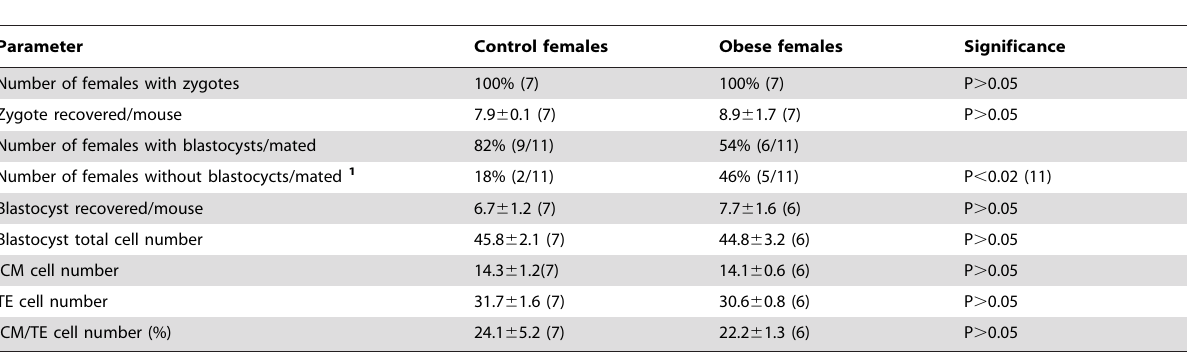
Table 2. The influence of maternal diet –induced obesity on early embryo development.